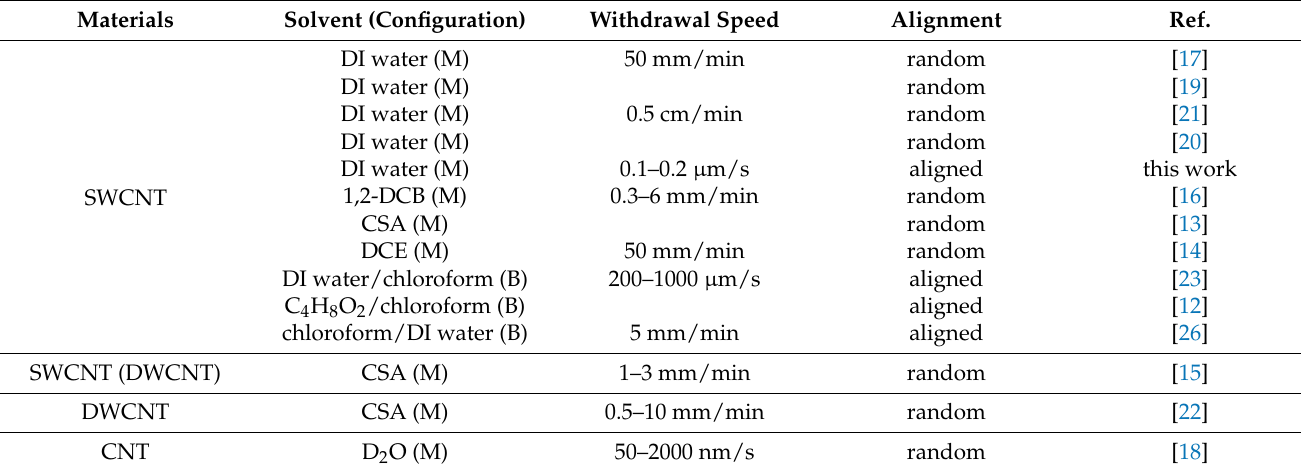
Table 1. Comparison of Various Dip-coating Approaches for Aqueous Suspension. (M: mono-phasic; B: